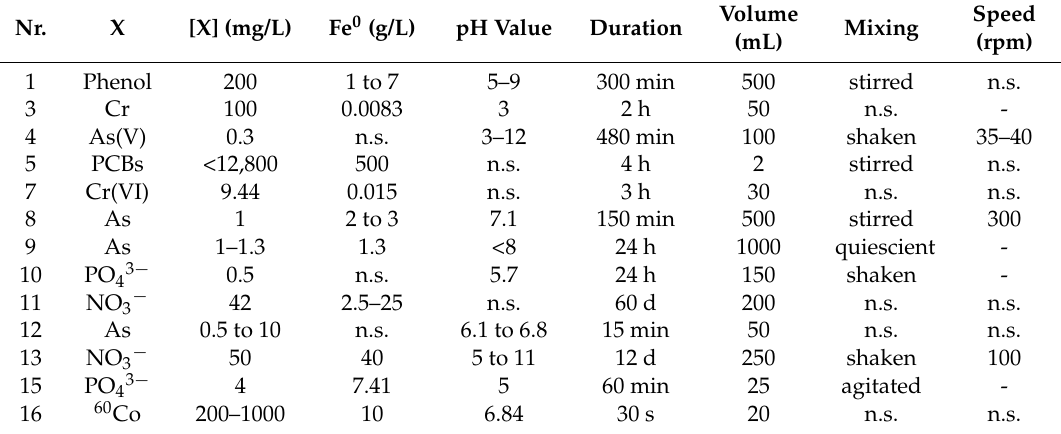
Table 3. Summary of some experimental conditions used for the batch experiments in 13 of the peer-reviewed articles using steel wool for contaminant removal. The numbers (Nr.) are related to relevant references as specified in Table 2. Polychlorinated biphenyls are abbreviated to: “PCBs”. X stands for the used contaminant and [X] for its concentration.